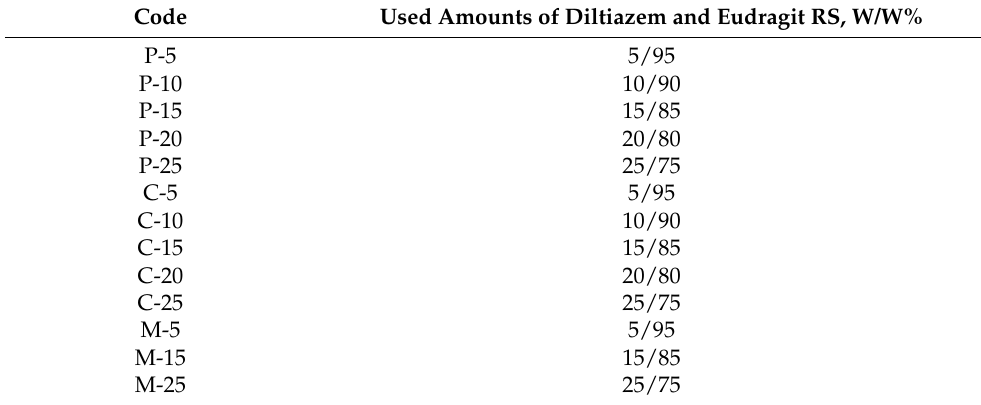
Table 1. Mass ratios of diltiazem and the polymer Eudragit RS 100. Code Used Amounts of Diltiazem and Eudragit RS, W/W% P-5